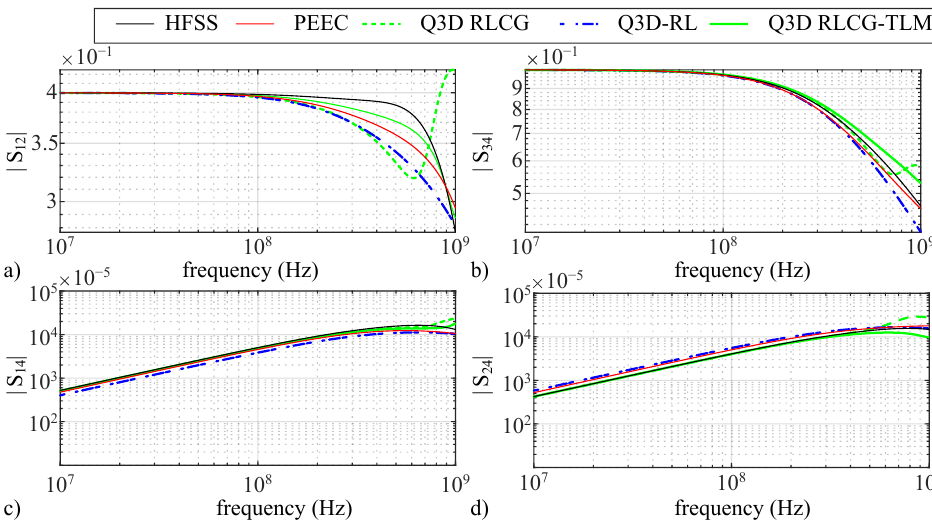
Figure 4. The magnitude of selected S parameters calculated in the HF range by the PEEC solver developed in-house, the HFSS 3-D FEM solver, the Q3D RLCG-solver, the Q3D RLCG-solver with TLM, and the Q3D RL-solver: ( a ) S 12 , ( b ) S 14 , ( c ) S 34 and ( d ) S 24